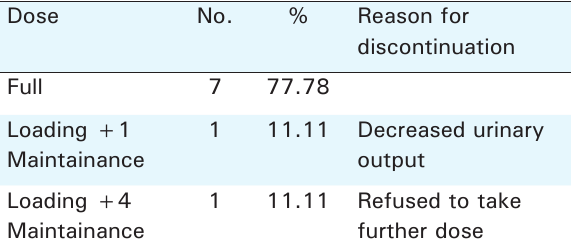
Table 5. Dose of MgSO4 in Severe Pre-eclampsia